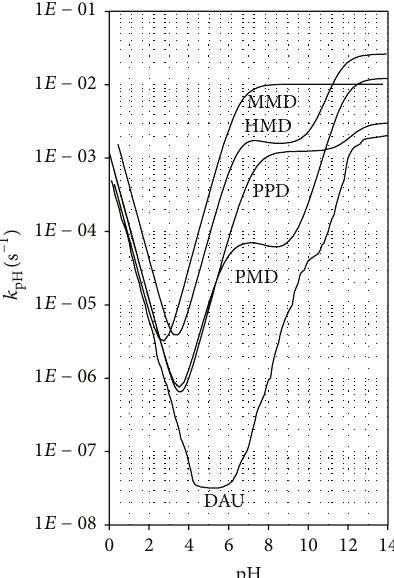
Figure 6: log 𝑘 = 𝑓 (pH) profiles of daunorubicin (DAU) and its pH four amidine derivatives: N -[(pyrrolidine)methylene]daunorubicin (PMD), N -[(morpholine) methylene]daunorubicin (MMD), aqueous solutions at 313